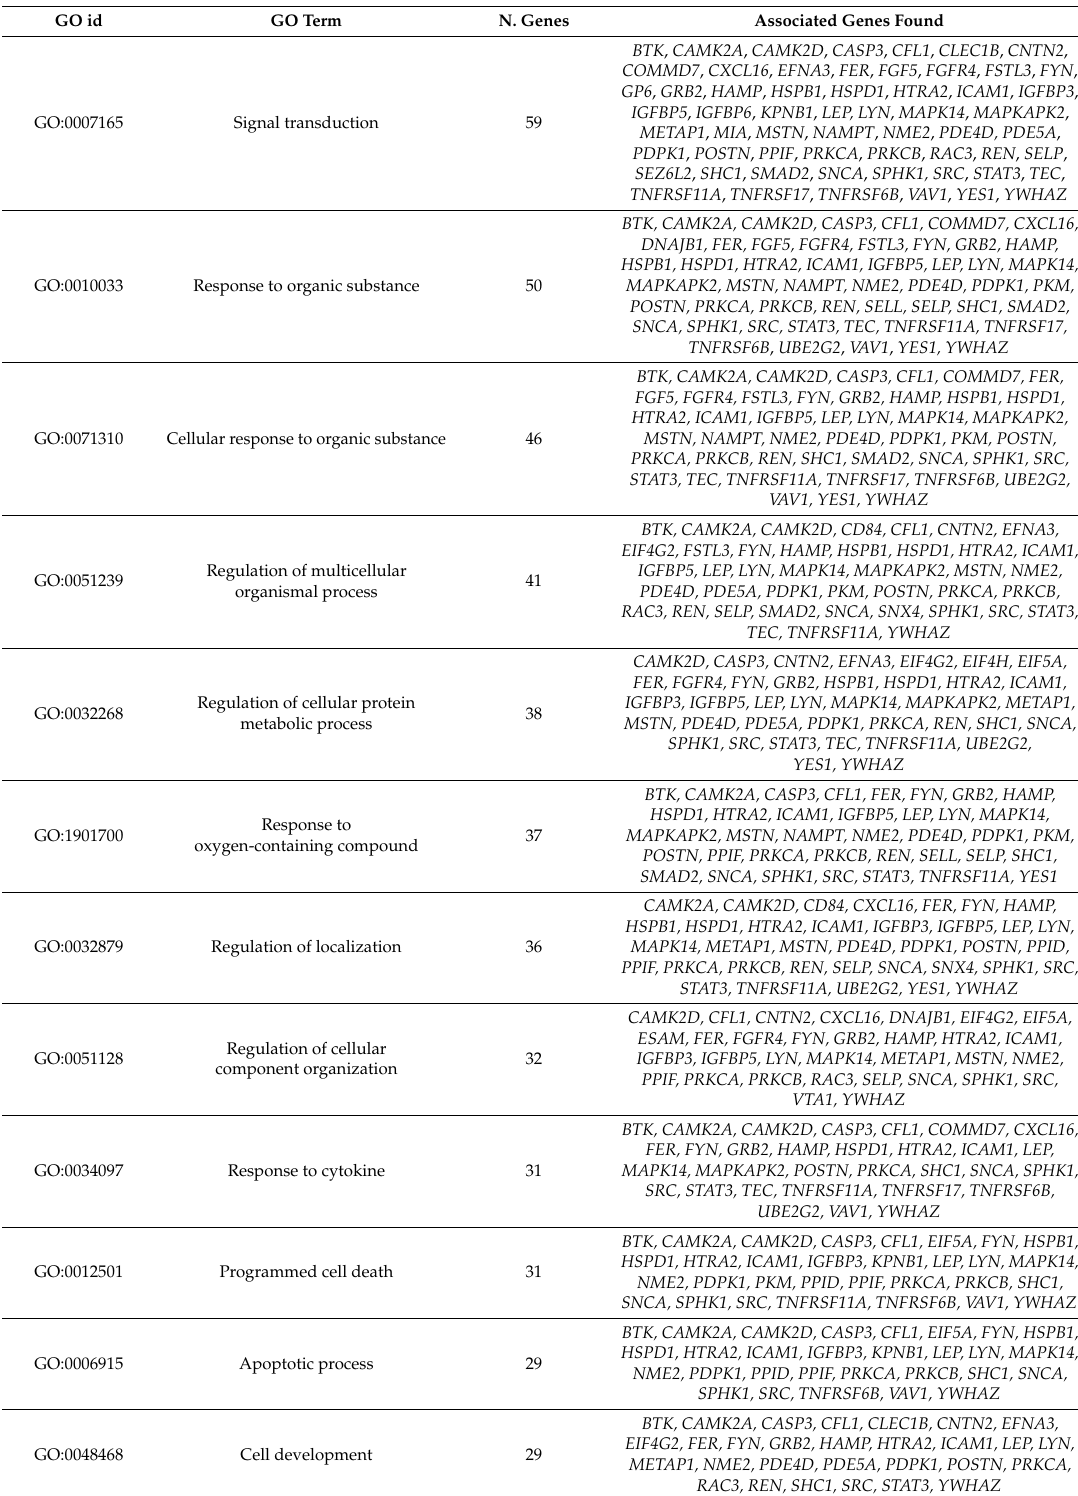
Table 4. Significantly enriched gene ontology (GO) pathways in the association with muscle mitochondrial oxidative capacity, adjusting for age and